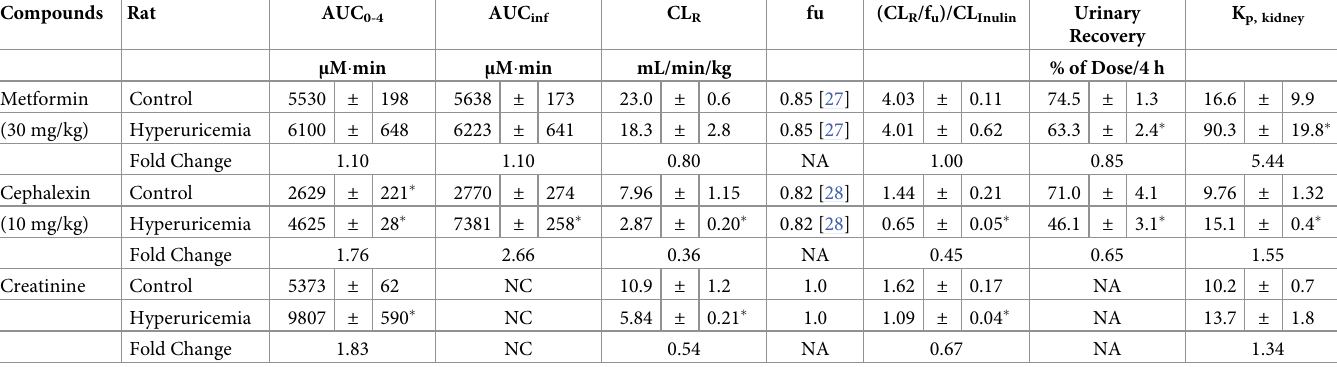
Values were determined from the data shown in Fig 3. Values are presented as mean ± SEM (n = 3). f u of creatinine was set at 1.0. � p < 0.05 vs. control rats.